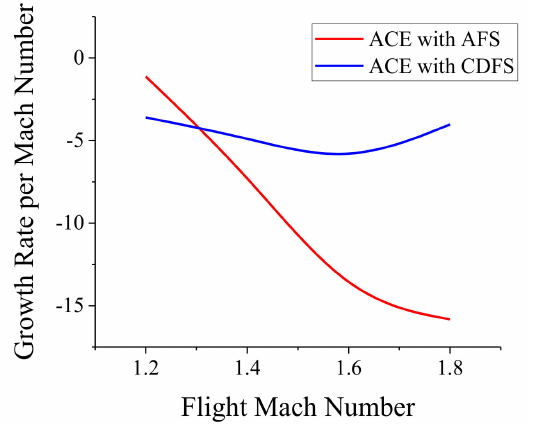
Figure 7. The Surge Margin Growth Rate Comparison of Front